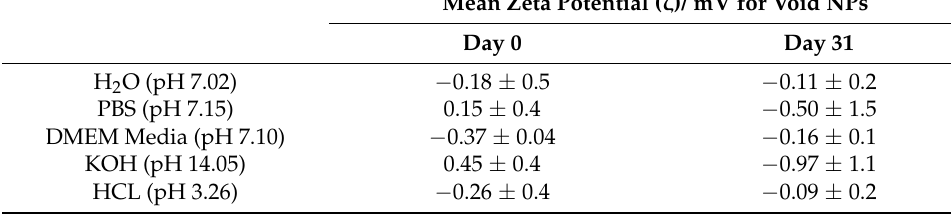
of the five instrument runs for each sample ± SD. HCL: hydrochloride; KOH: potassium hydroxide; PBS: phosphate buffer saline; DMEM: Dulbecco’s Modified Eagle